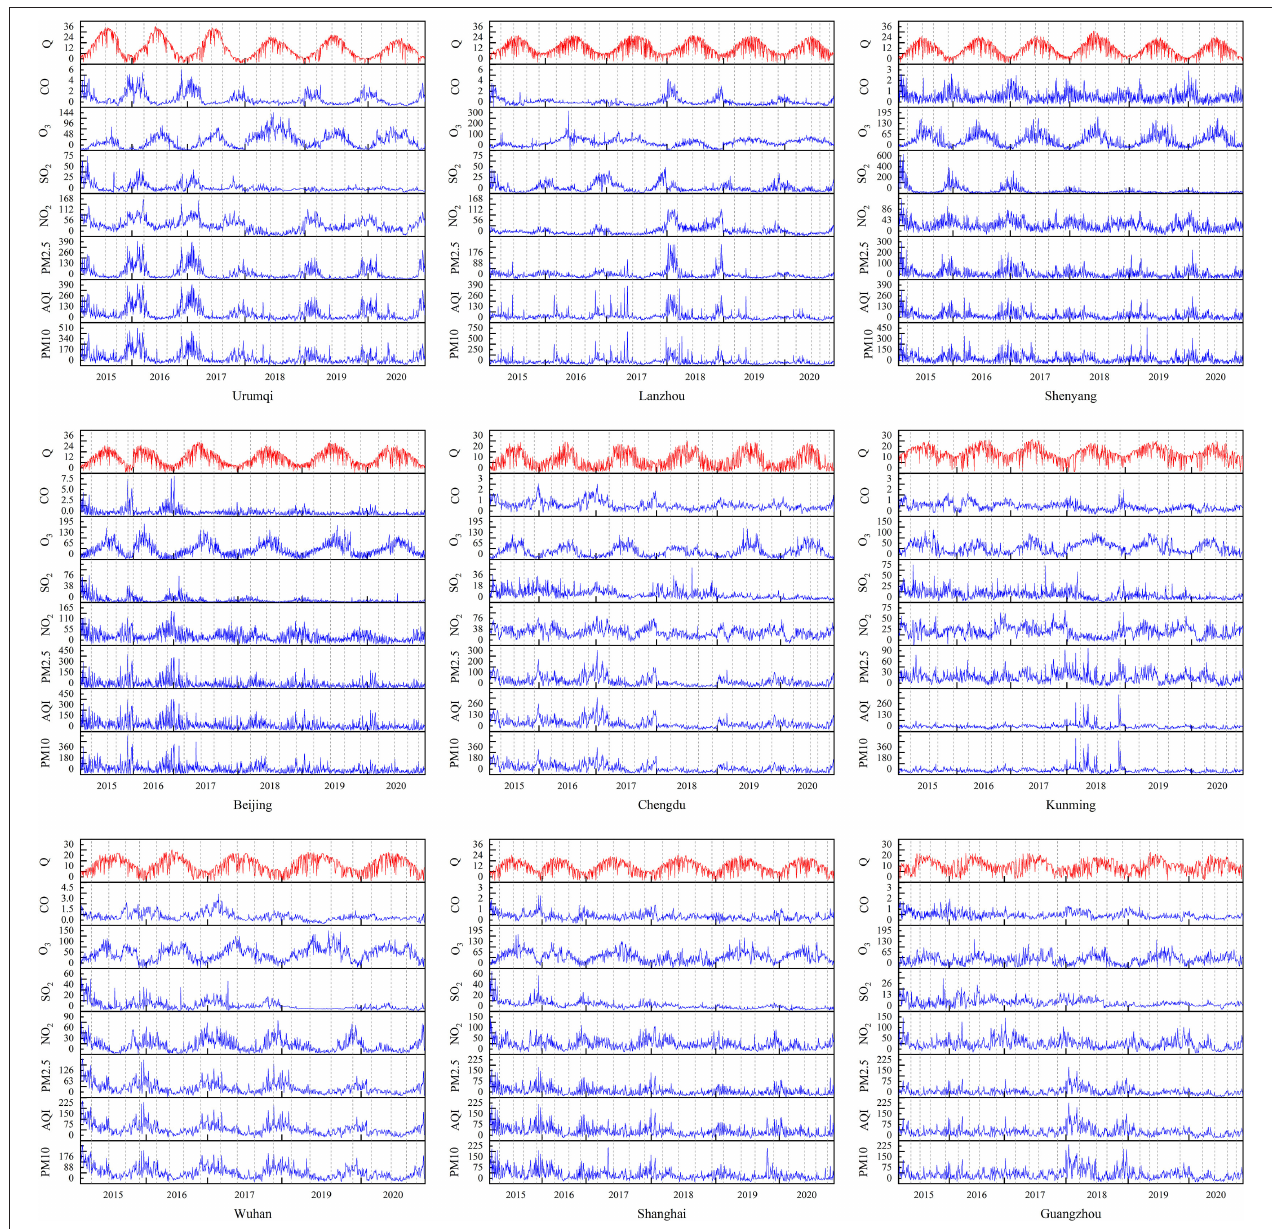
FIGURE 3 | Daily global solar radiation and pollution parameters from 2015 to 2020 in nine cities (Wuhan lacks 2018